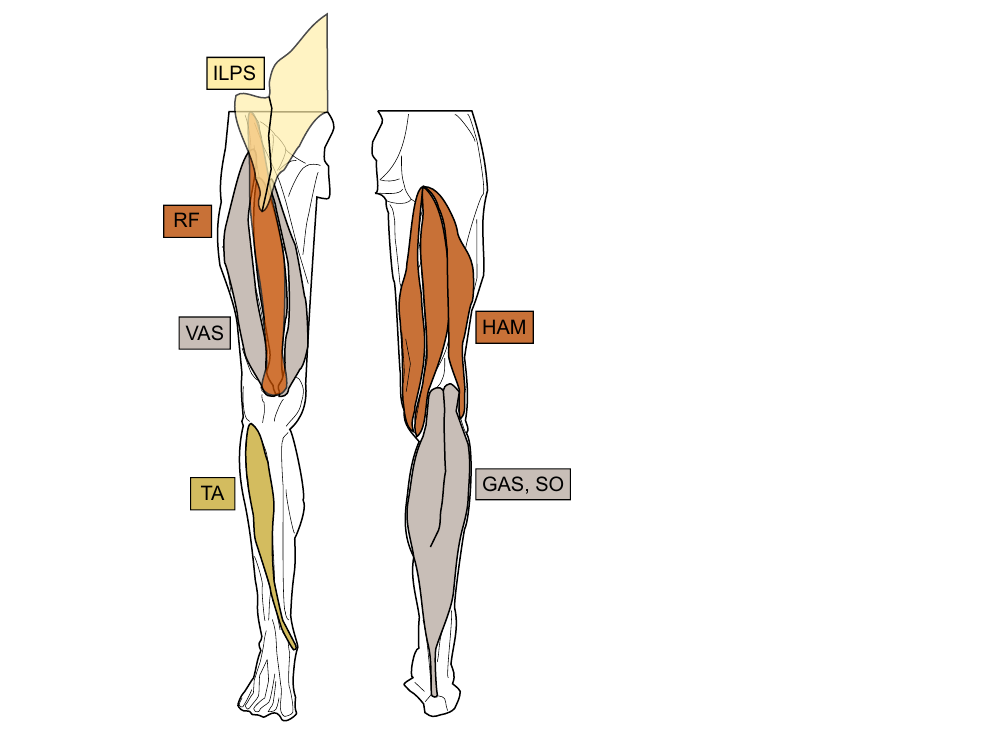
Figure 1. Location and abbreviations of muscles referred in this study. ILPS: iliopsoas muscle, RF: rectus femoris muscle, VAS: vastii muscle group, HAM: hamstring muscle group, GAS: gastrocnemius muscle, SO: soleus muscle, TA: tibialis